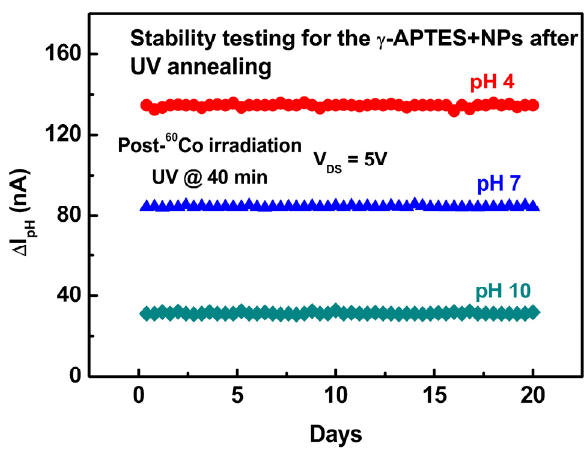
Figure 9. Consecutive pH tests for the γ -APTES+NPs/native-oxide/PSW pH-sensitive sensors with 40-min post-sterilization UV